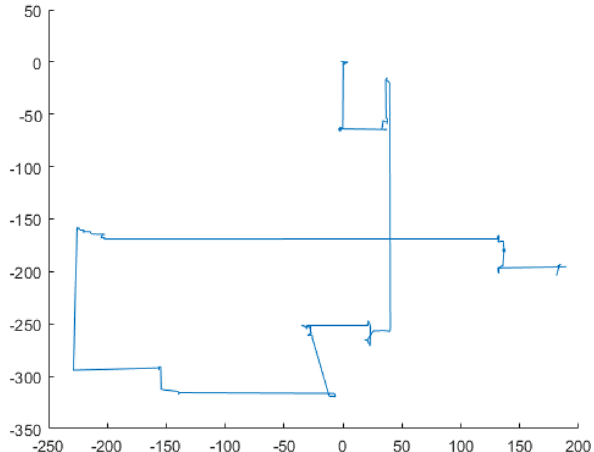
Figure 3. Levy flight simulation trajectory.